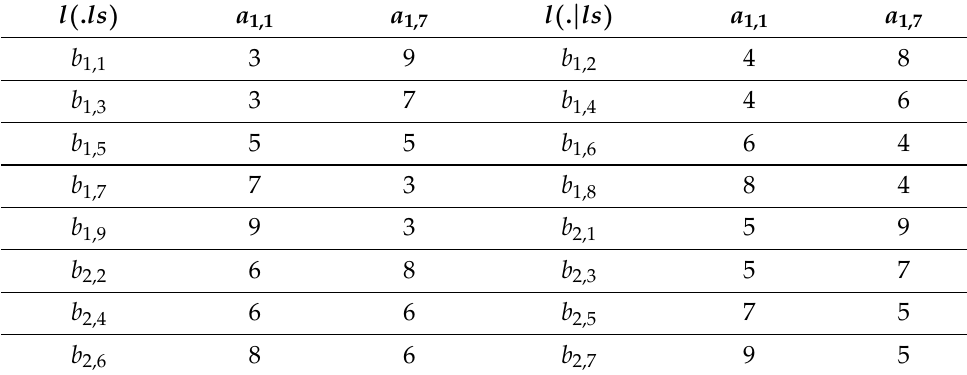
Table 2. Locations of the nodes of GHCN ( 2,2,3 )